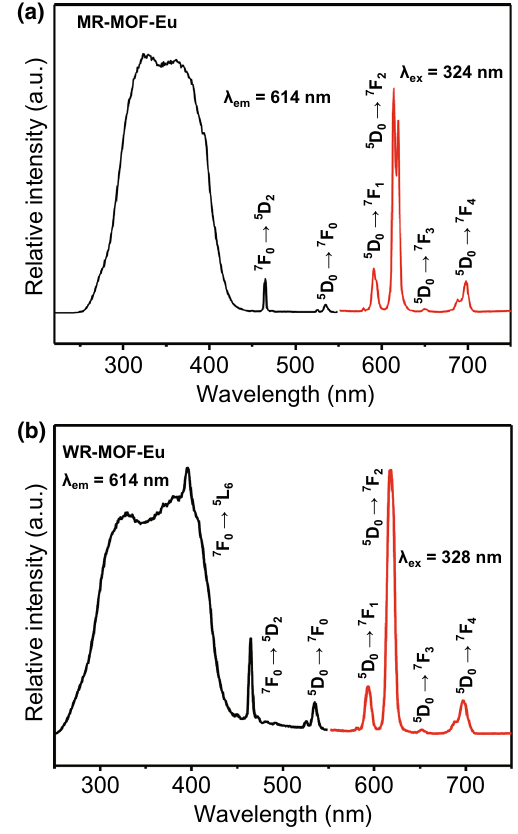
Fig. 10 Excitation (black line) and emission (red line) spectra of a MR-MOF-Eu and b WR-MOF-Eu hybrid materials. Reprinted with permission from Ref. [42]. Copyright 2020, Elsevier. (Color figure online)